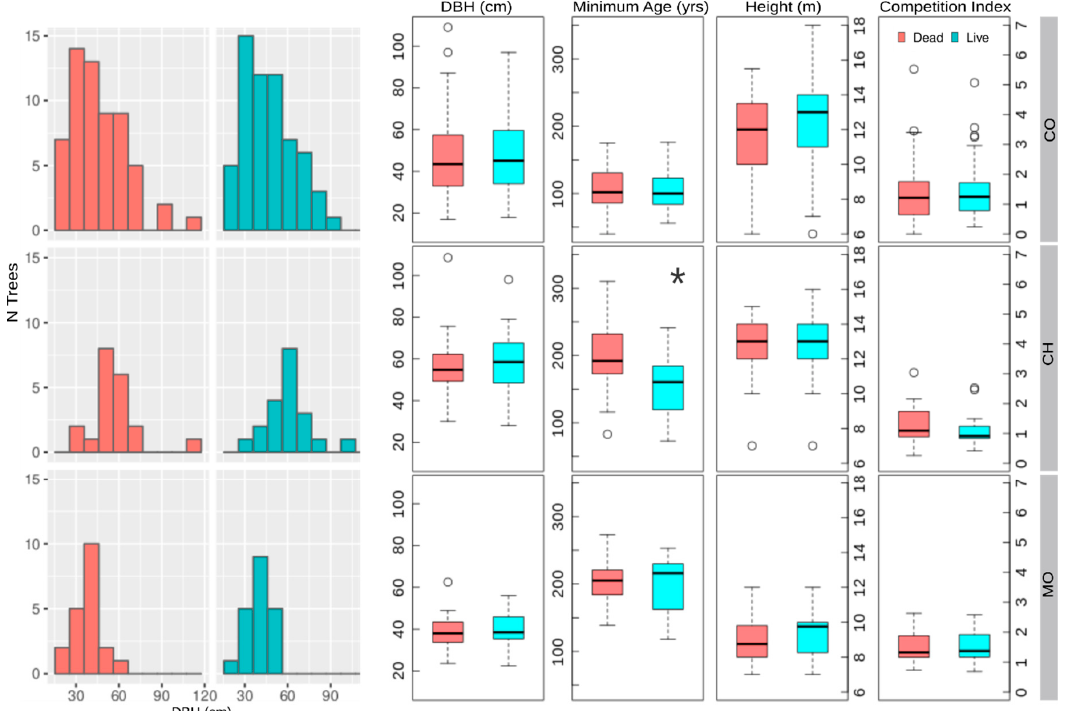
Figure 1 . Frequency distribution of diameter at breast height (DBH), and box and whisker plots for DBH, minimum age at sampling height, height, and CI H for dead and live trees in Paso Córdova (CO), Challhuaco (CH), and Perito Moreno (MO) sites. Significant differences according to the Kruskal-Wallis test are indicated with an asterisk.